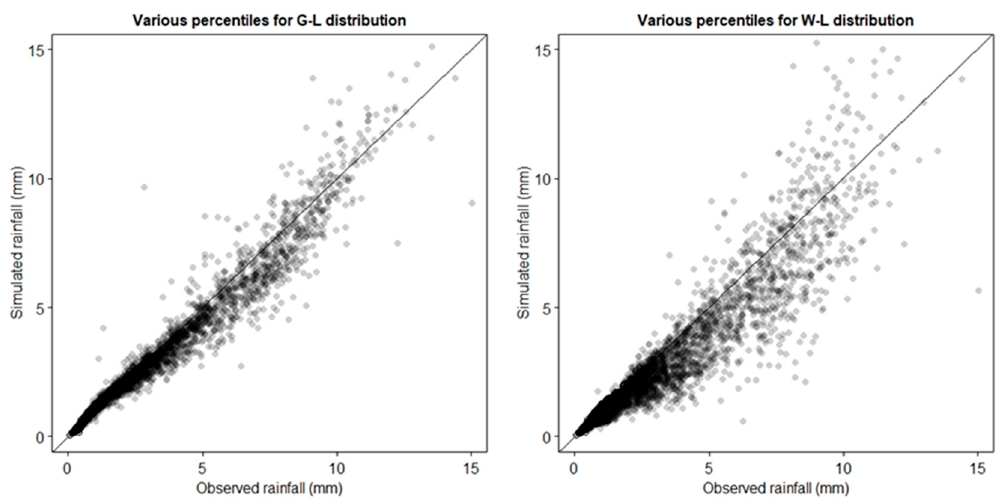
Figure 4. The scatter plot presenting various percentiles of observed and simulated (by fitted parameters) sub-daily rainfall.